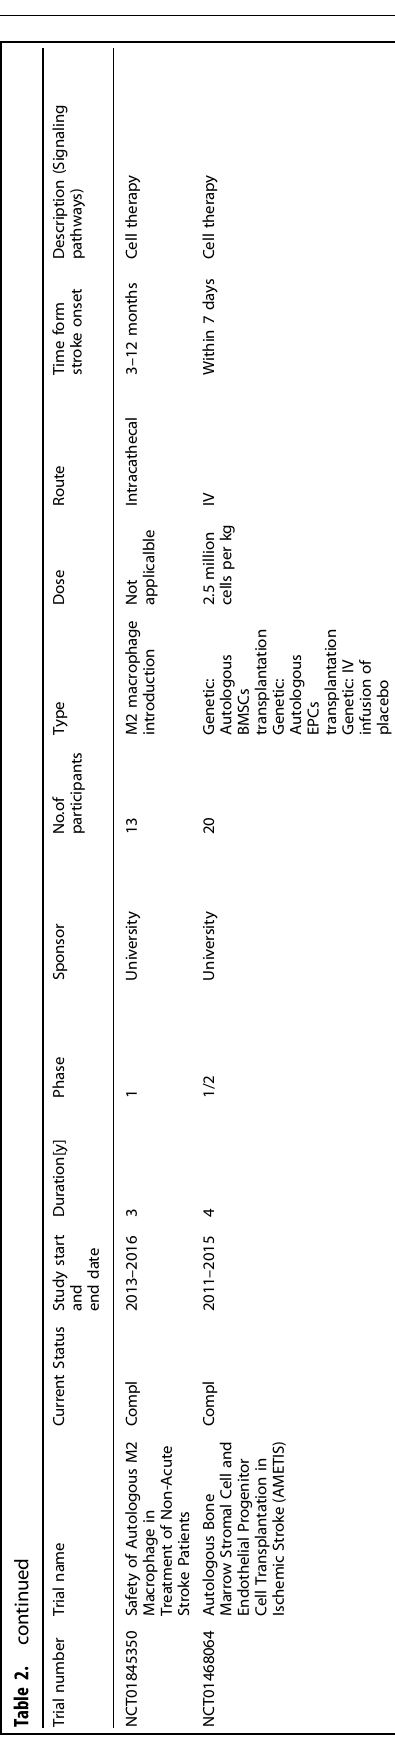
Signal Transduction and Targeted Therapy (2022)